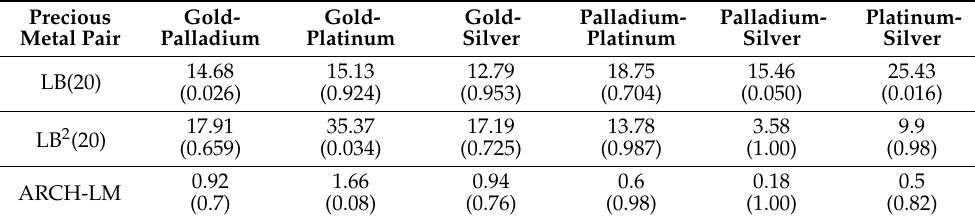
Table A3. Diagnostic of the GARCH (1,1)